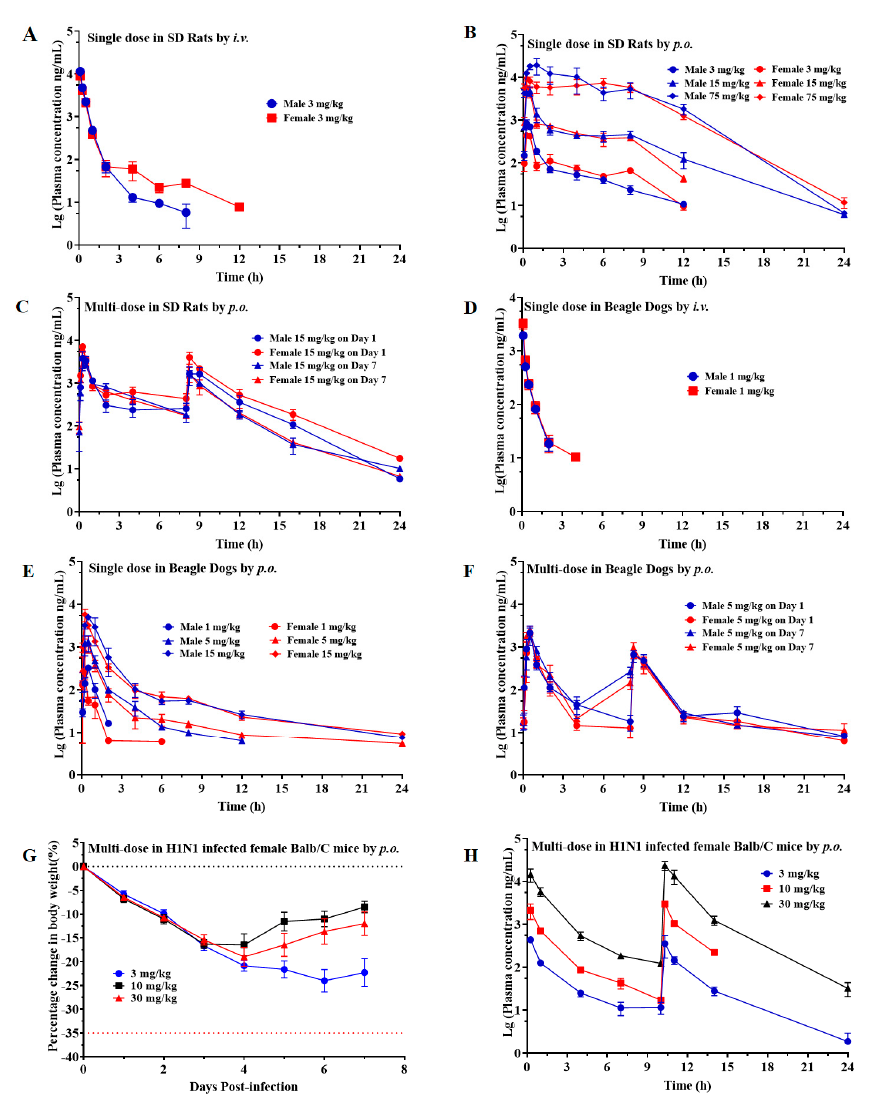
Figure 10. Pharmacokinetic study of ZSP1273 in SD rats, beagle dogs, and mice (n = 3, mean ± SEM): ( A ) The 24 h concentration–time curves of single-dose ZSP1273 in rats administered i.v. ( B ) The 24 h concentration-time curves of single-dose ZSP1273 in rats administered p.o. ( C ) The 24 h concentration-time curves of multi-dose ZSP1273 in rats administered p.o. ( D ) The 24 h concentration-time curves of single-dose ZSP1273 in rats administered i.v. ( E ) The 24 h concentration-time curves of single-dose ZSP1273 in beagle dogs administered p.o. ( F ) The 24 h concentration-time curves of multi-dose ZSP1273 in beagle dogs administered p.o. ( G ) Changes in the weight of H1N1-infected female BALB/c mice over 7 days. ( H ) The 24 h concentration-time curves of continuous multi-dose ZSP1273 (3, 10, and 30 mg/kg, twice daily, for 7 days) in H1N1-infected female BALB/c mice administered p.o. Error bars represent the standard error of the mean value. After twice-daily oral administration of ZSP1273 at 3 mg/kg, 10 mg/kg, and 30 mg/kg in H1N1-infected female BALB/c mice for 7 consecutive days, the weight of mice